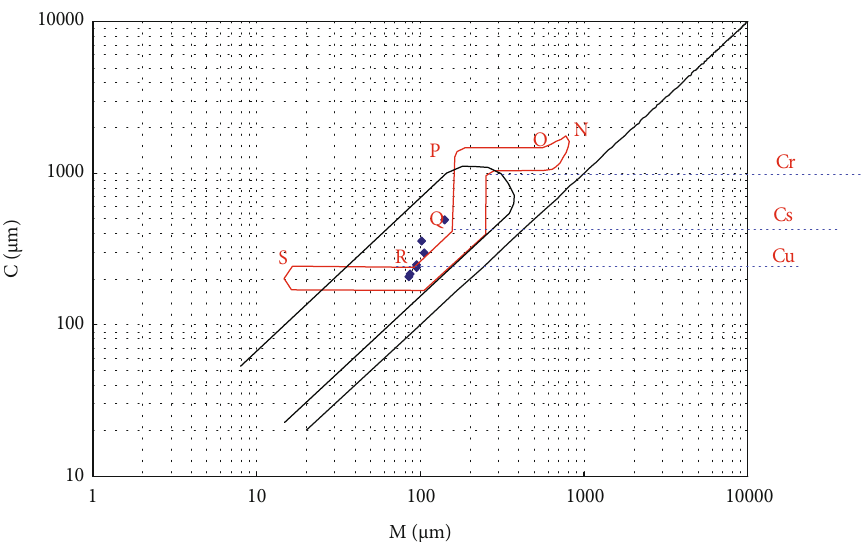
Figure 5: C-M map of Paleogene Kumugelimu Formation reservoir in Yingmai 7